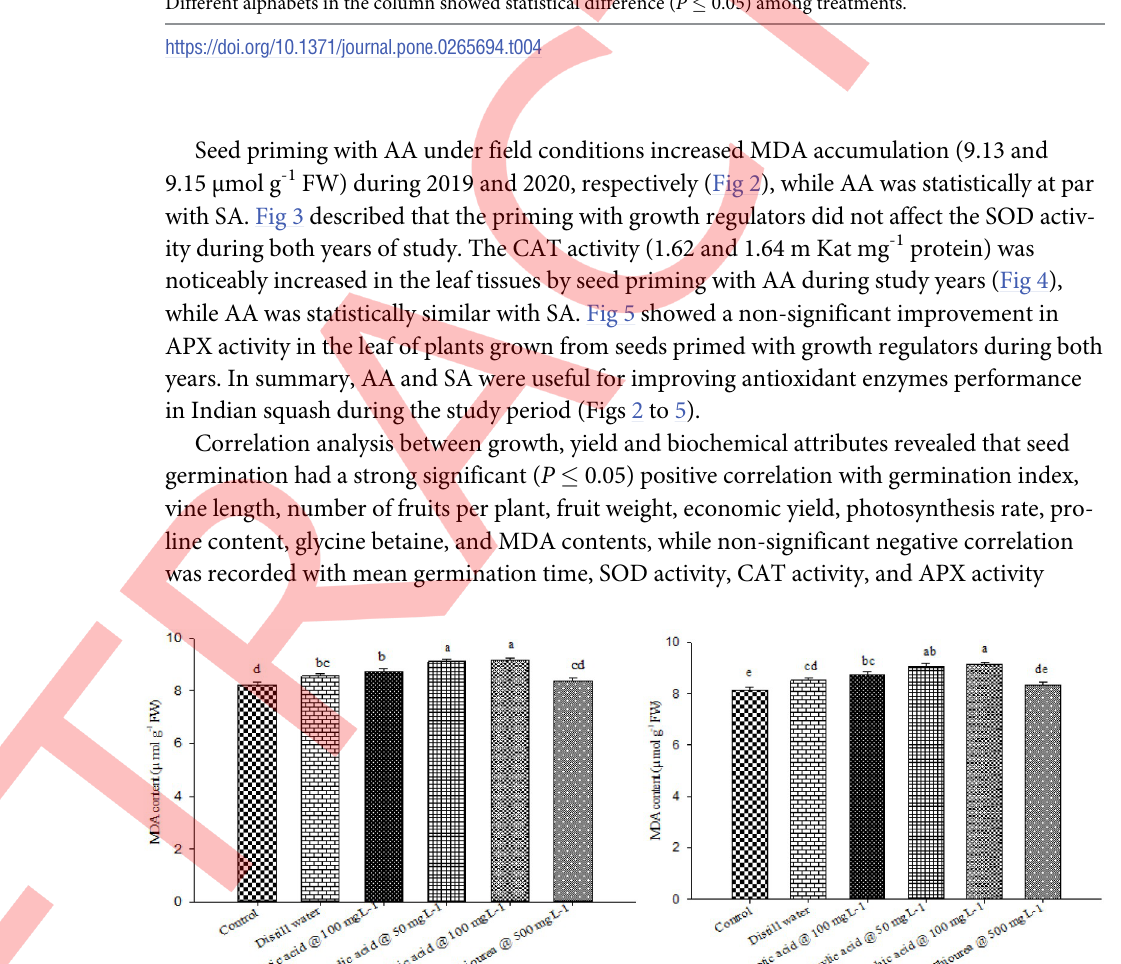
Different alphabets in the column showed statistical difference ( P � 0.05) among treatments.